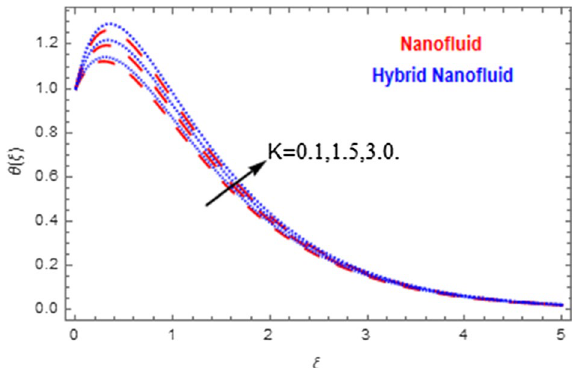
Figure 12. Variation in temperature field of nanofluid ( Al 2 O 3 ) and hybrid nanofluid ( Al 2 O 3 , Cu ) against different estimations of K .